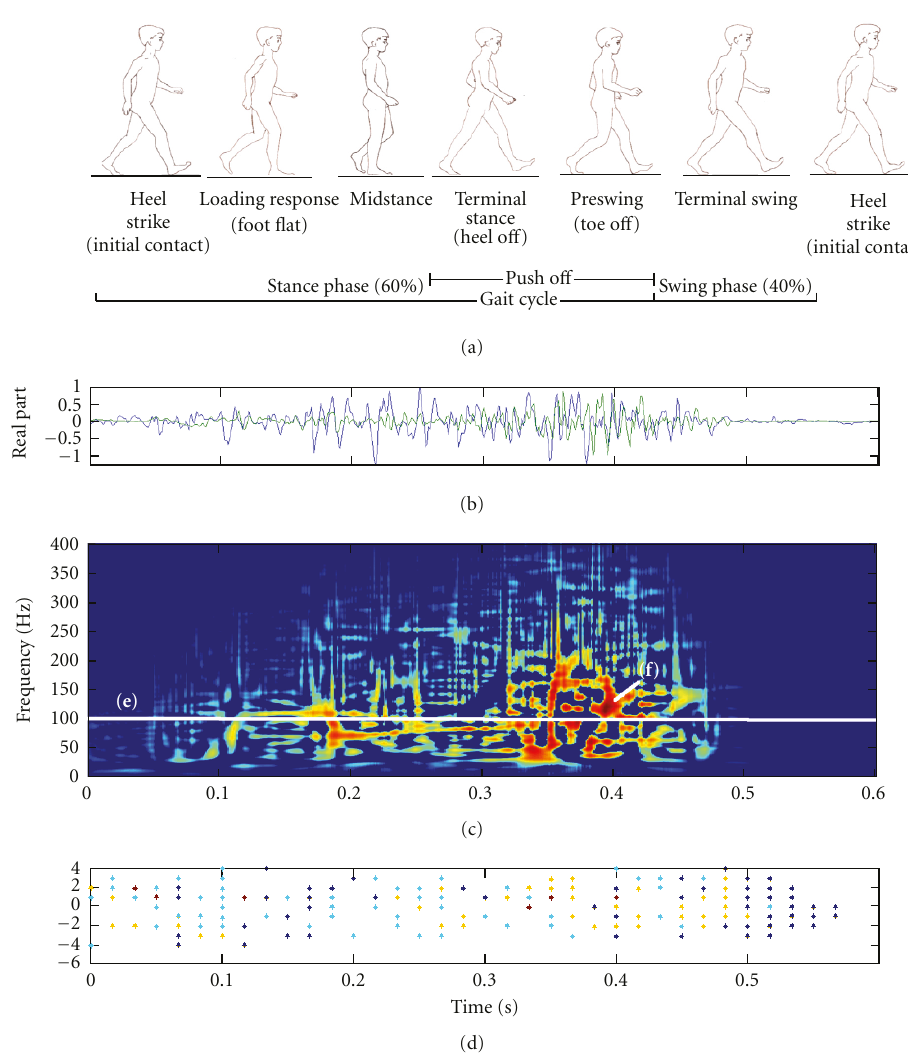
Figure 4: Time − aligned (a) gait cycle, (b) time − domain waveform of two EMG footfall wave packets, (c) cross time − frequency visualization of two EMG footfall wave packets, (d) line denoting separation of measure for energy above 100Hz, (e) location of peak energy and time − bandwidth measures, (f) recording of pressure data from time − synchronized mat.